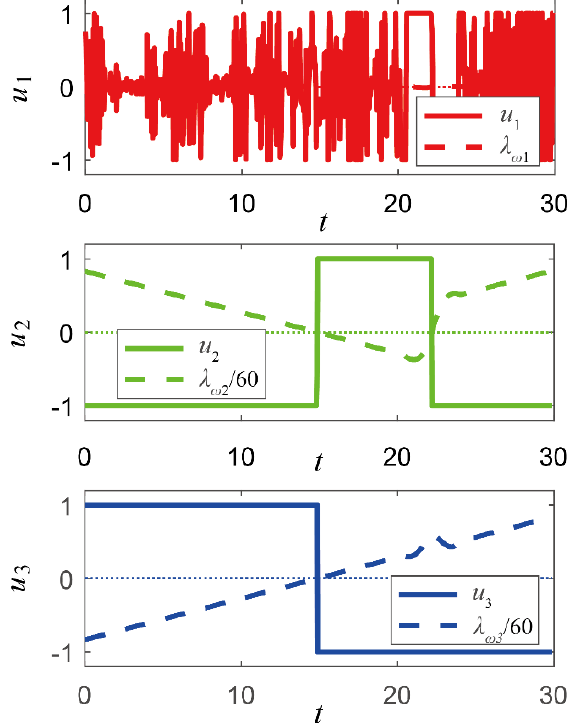
Figure 12. The 3D representation of the time-optimal reorientation for Case 11.